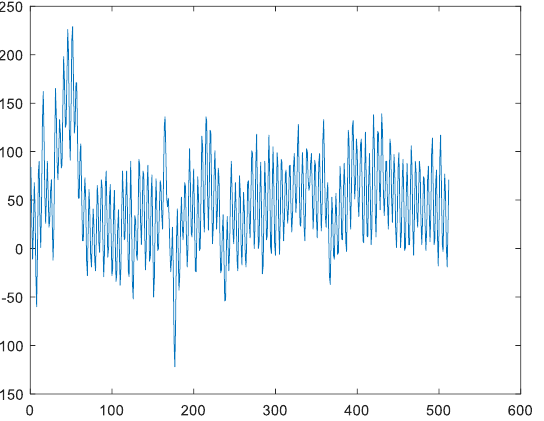
Figure 4. An example of a sample of the EEG when Danny is conducting the drawing activity under the concentration state. the concentration state.